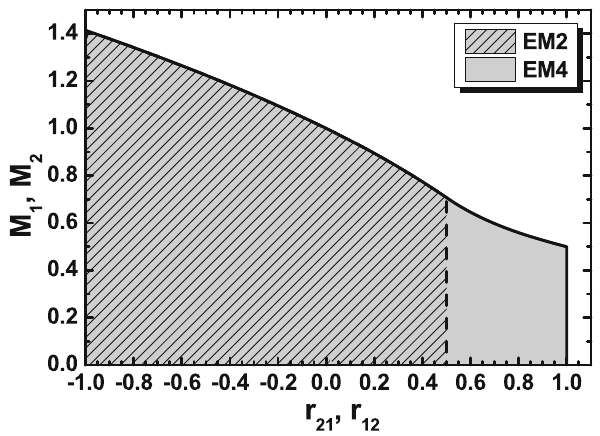
Fig. 2 Allowed regions in the r 21 − M 1 (lined region) for EM2 and | r | ≤ 1 and in the r 21